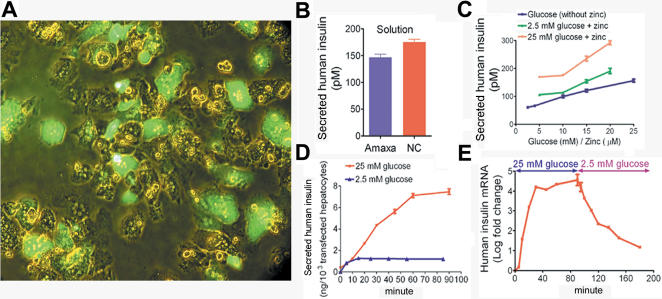
Regulated insulin secretion by electroporated primary porcine hepatocytes ex vivo.(A) Electroporation using Amaxa™ solution transfected 40–50% hepatocytes with pEGFP. Merged brightfield and fluorescence images; original magnification 200×. (B) Human insulin concentration in 24 h conditioned media of primary hepatocytes electroporated with p3MTChins (2 µg/106 cells) in Amaxa or NC solutions (p = 0.0026). (C) Human insulin concentration in 24 h conditioned media of p3MTChins-electroporated hepatocytes. Thresholds for stimulating insulin secretion were 4 mM glucose (p = 0.0018 cf. 2.5 mM glucose) and 5 µM zinc (p<0.0001 cf. no zinc). Data are means±s.e.m. of quadruplicate experiments. (D) Time course of insulin secretion by electroporated hepatocytes. Insulin secretion increased from 0.01 to 0.14 ng/103 hepatocytes/min (p<0.0001) after 5 min in 25 mM glucose but not in 2.5 mM glucose over 85 min. Data are means±s.e.m of quadruplicate experiments from 2 primary hepatocyte preparations. (E) Insulin mRNA, quantified by real time RT-PCR after subtracting a parallel minus-RT control and normalising to HPRT1 mRNA [19], rose within 5 min in 25 mM glucose (p<0.0001) and fell within 10 min in 2.5 mM glucose (p = 0.0149). Values are mean±s.e.m. of triplicate experiments.